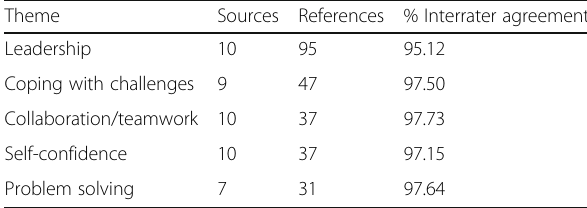
Table 3 Resultant themes from coding